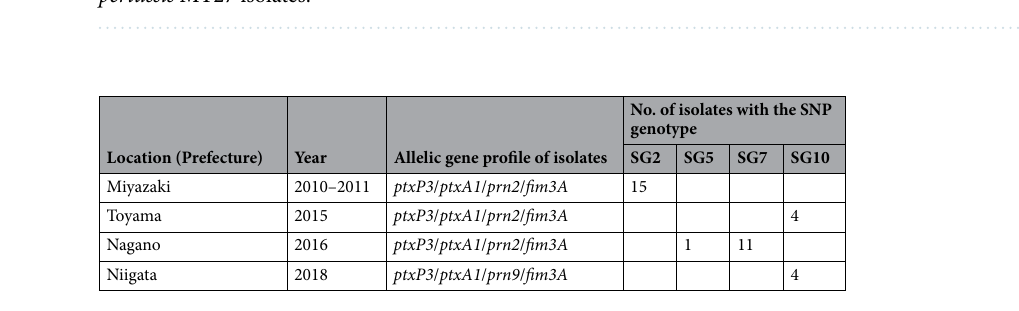
Table 4. Relationship between SNP genotypes and virulence-associated allelic gene profiles in 237 Bordetella pertussis MT27 isolates.